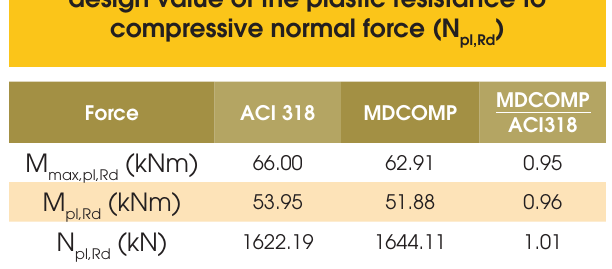
Table 5 – Maximum design value of the plastic resistance moment (M ), design value max,pl,Rd of the plastic resistance moment (M ) and pl,Rd design value of the plastic resistance to compressive normal force (N ) pl,Rd